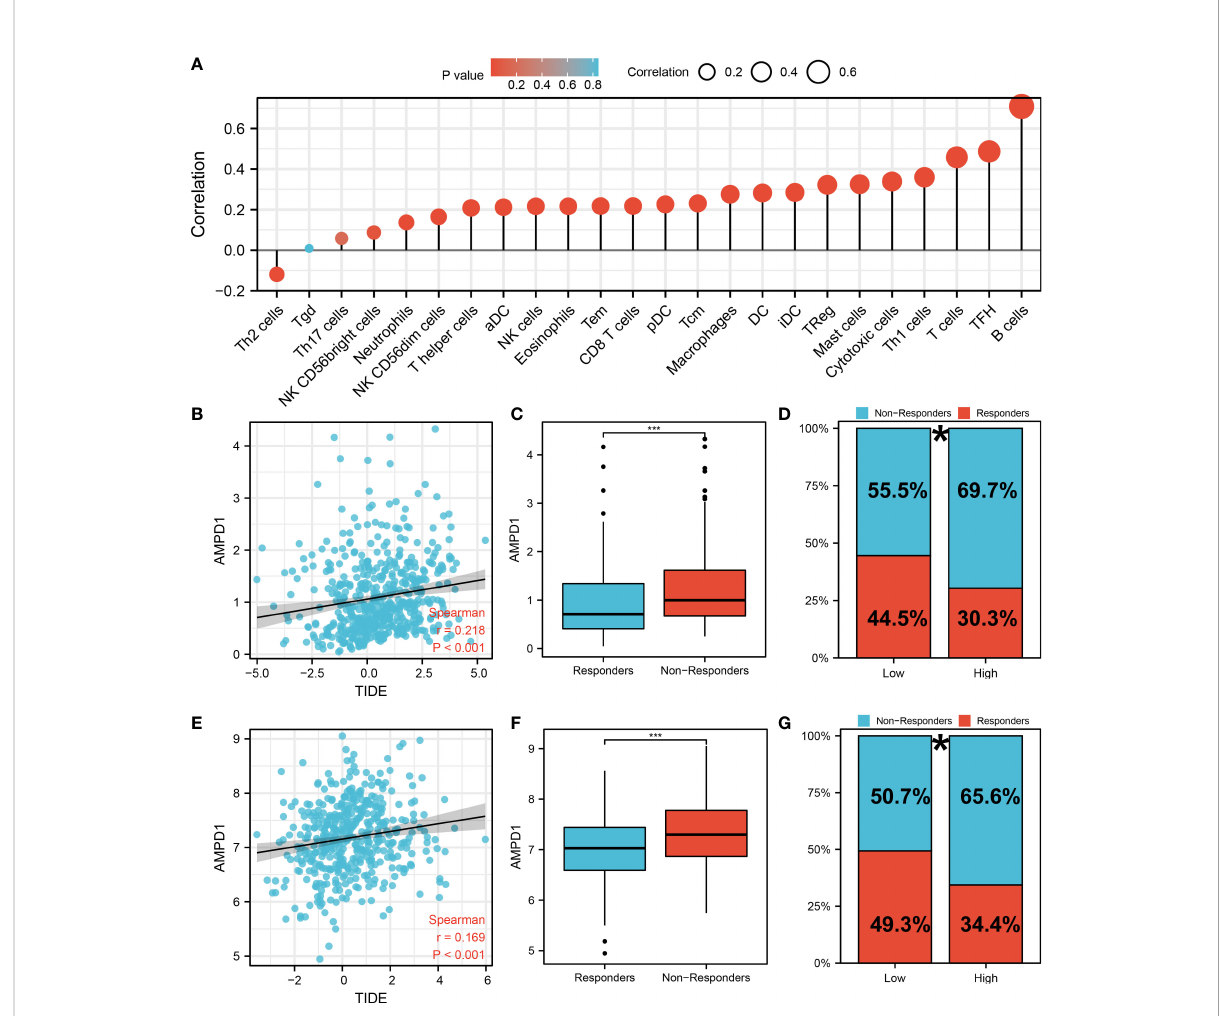
FIGURE 9 Immune-related analysis of AMPD1 in lung cancer. (A) The immune cell in fi ltration reveals that B cells, TFH, T cells, Th1 cells, cytotoxic cells and mast cells are positively correlated with the expression of AMPD1; (B) The correlation analysis between TIDE score and expression level of AMPD1 in TCGA cohort; (C) The AMPD1 expression in immunotherapy responders and non-responders (TCGA cohort), ***P < 0.001; (D) Percentage of immunotherapy responders and non-responders in high- and low-risk patients (TCGA cohort), *P <0.05; (E) The correlation analysis between TIDE score and expression level of AMPD1 in GSE68465 cohort; (F) The AMPD1 expression in immunotherapy responders and non-responders (GSE68465 cohort), ***P < 0.001; (G) Percentage of immunotherapy responders and non-responders in high- and low-risk patients (GSE68465 cohort), *P <